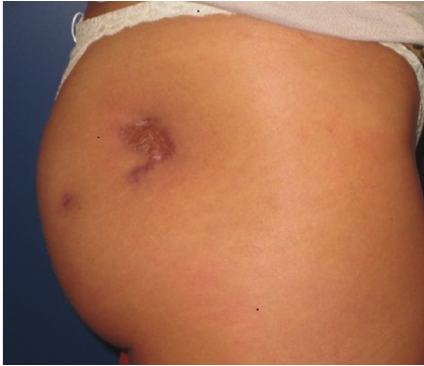
Figure 3: At six months’ follow-up, a hyperpigmented scar of a three-centimeter diameter was present in the middle of a depressed area of about seven centimetres in the right gluteal region. The scar is not hidden in a conventional swimming